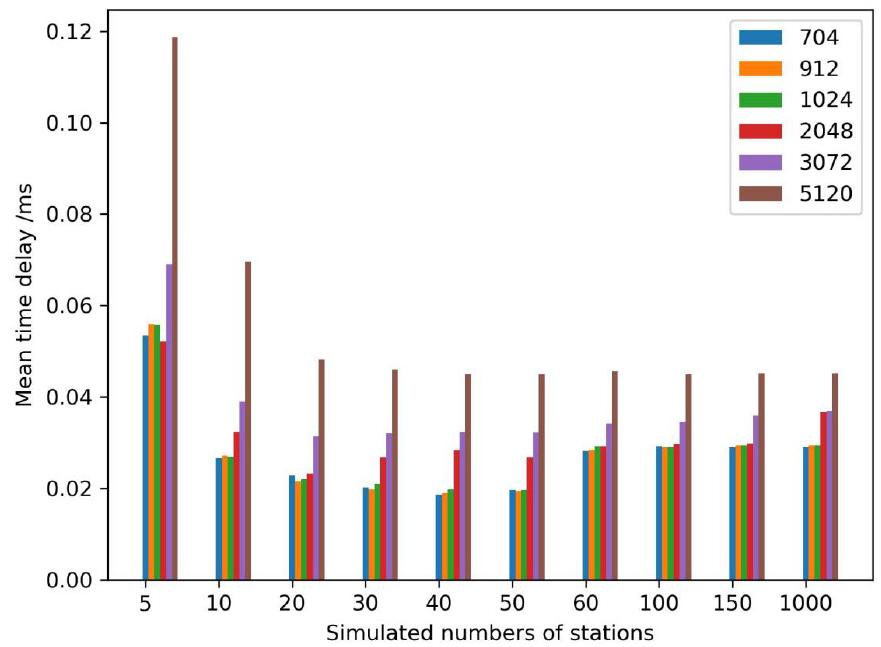
Figure 7. Encryption time delays of different simulated data volumes/bit.